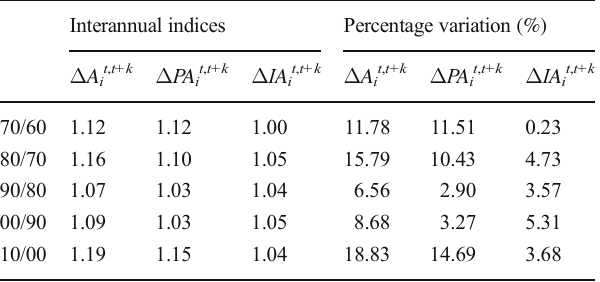
Decomposition of interannual Δ A it , t+k into population and infrastructure components Interannual